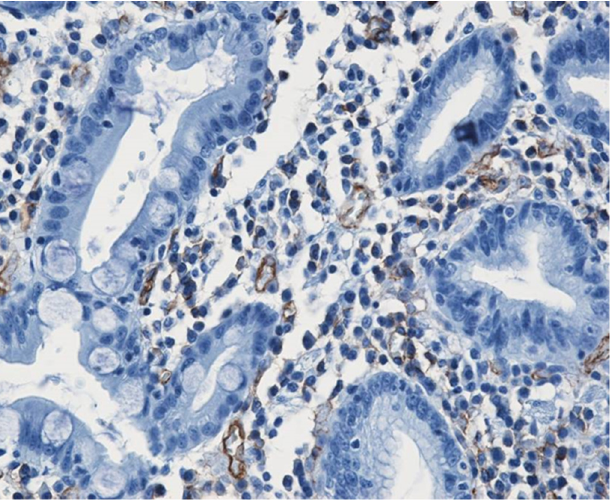
Figure 1. Small caliper blood vessels immunostained for CD34 antibody (DAB ×200).